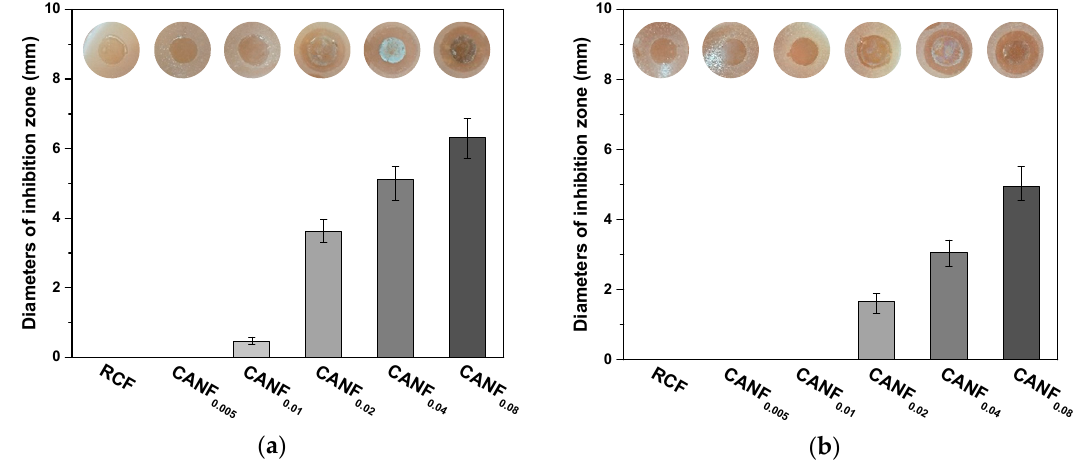
Figure 10. Inhibitory zone of composite films: ( a ) against E. coli and ( b ) against S. aureus .